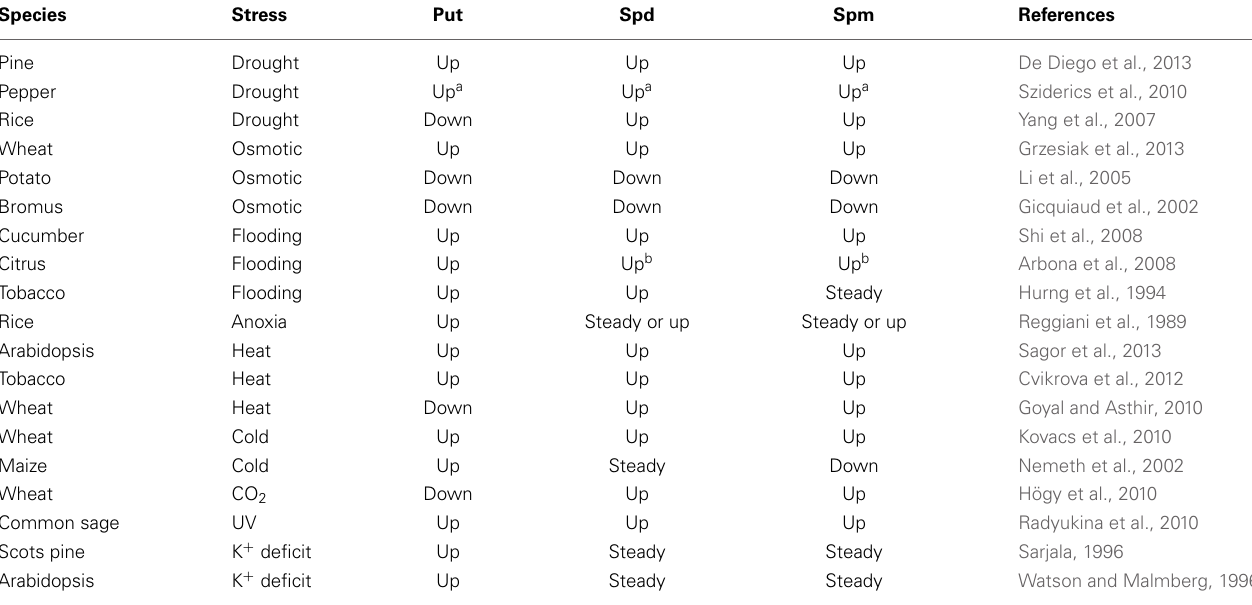
Table 1 | Stress-induced changes in the level of free polyamines in plants.